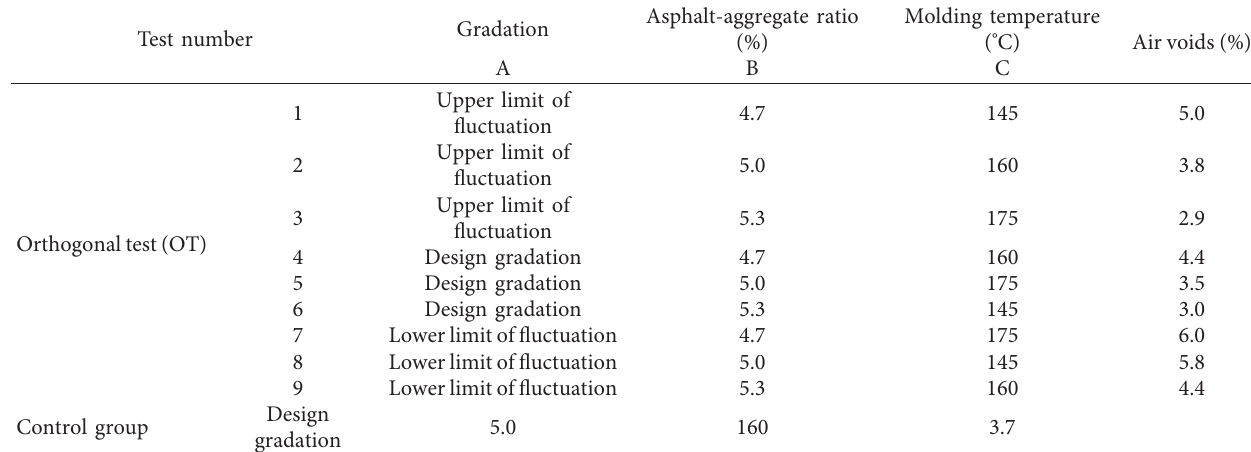
Figure 3: Allowable range of fluctuation in the gradation of the asphalt mixture. Table 5: Test results of Marshall